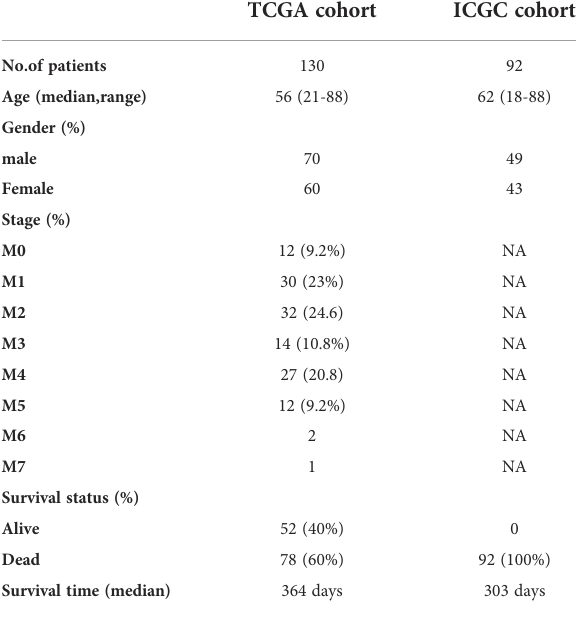
TABLE 1 Clinical characteristics of AML patients used in this study.